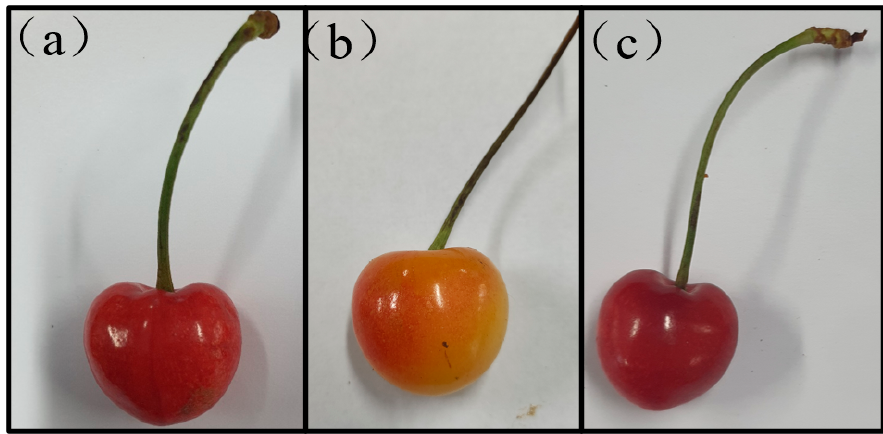
Figure 1. Three species of sweet cherries: ( a ) Tieton; ( b ) Huang Mi and ( c ) Lapins.